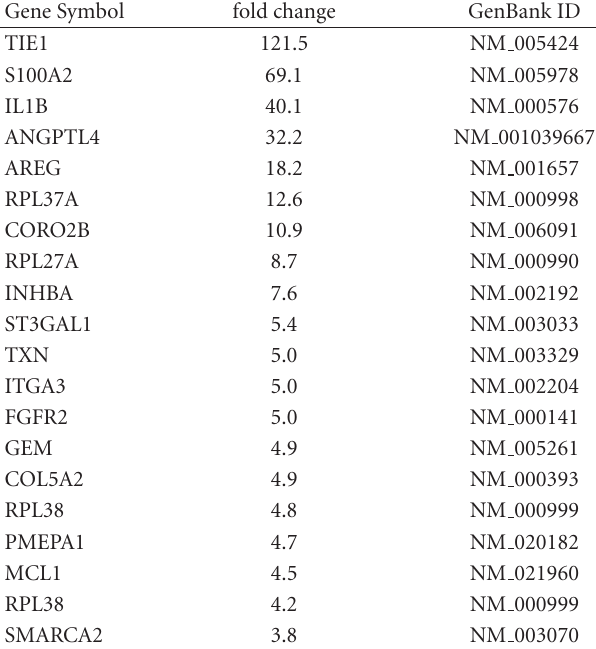
Table 1: Microarray Analysis of A375(DRO) cells after TZD/ rexinoid combination treatment—2-fold up regulated genes. A375(DRO) cells were treated in vitro with 1 μ mol/L of PIO or combination LGD1069/PIO for 24 hours compared with volume- equivalent vehicle in triplicate with a cuto ff of a 2-fold change ( P < . 5, one-way ANOVA). Gene symbols were derived from the A ff ymetrix web